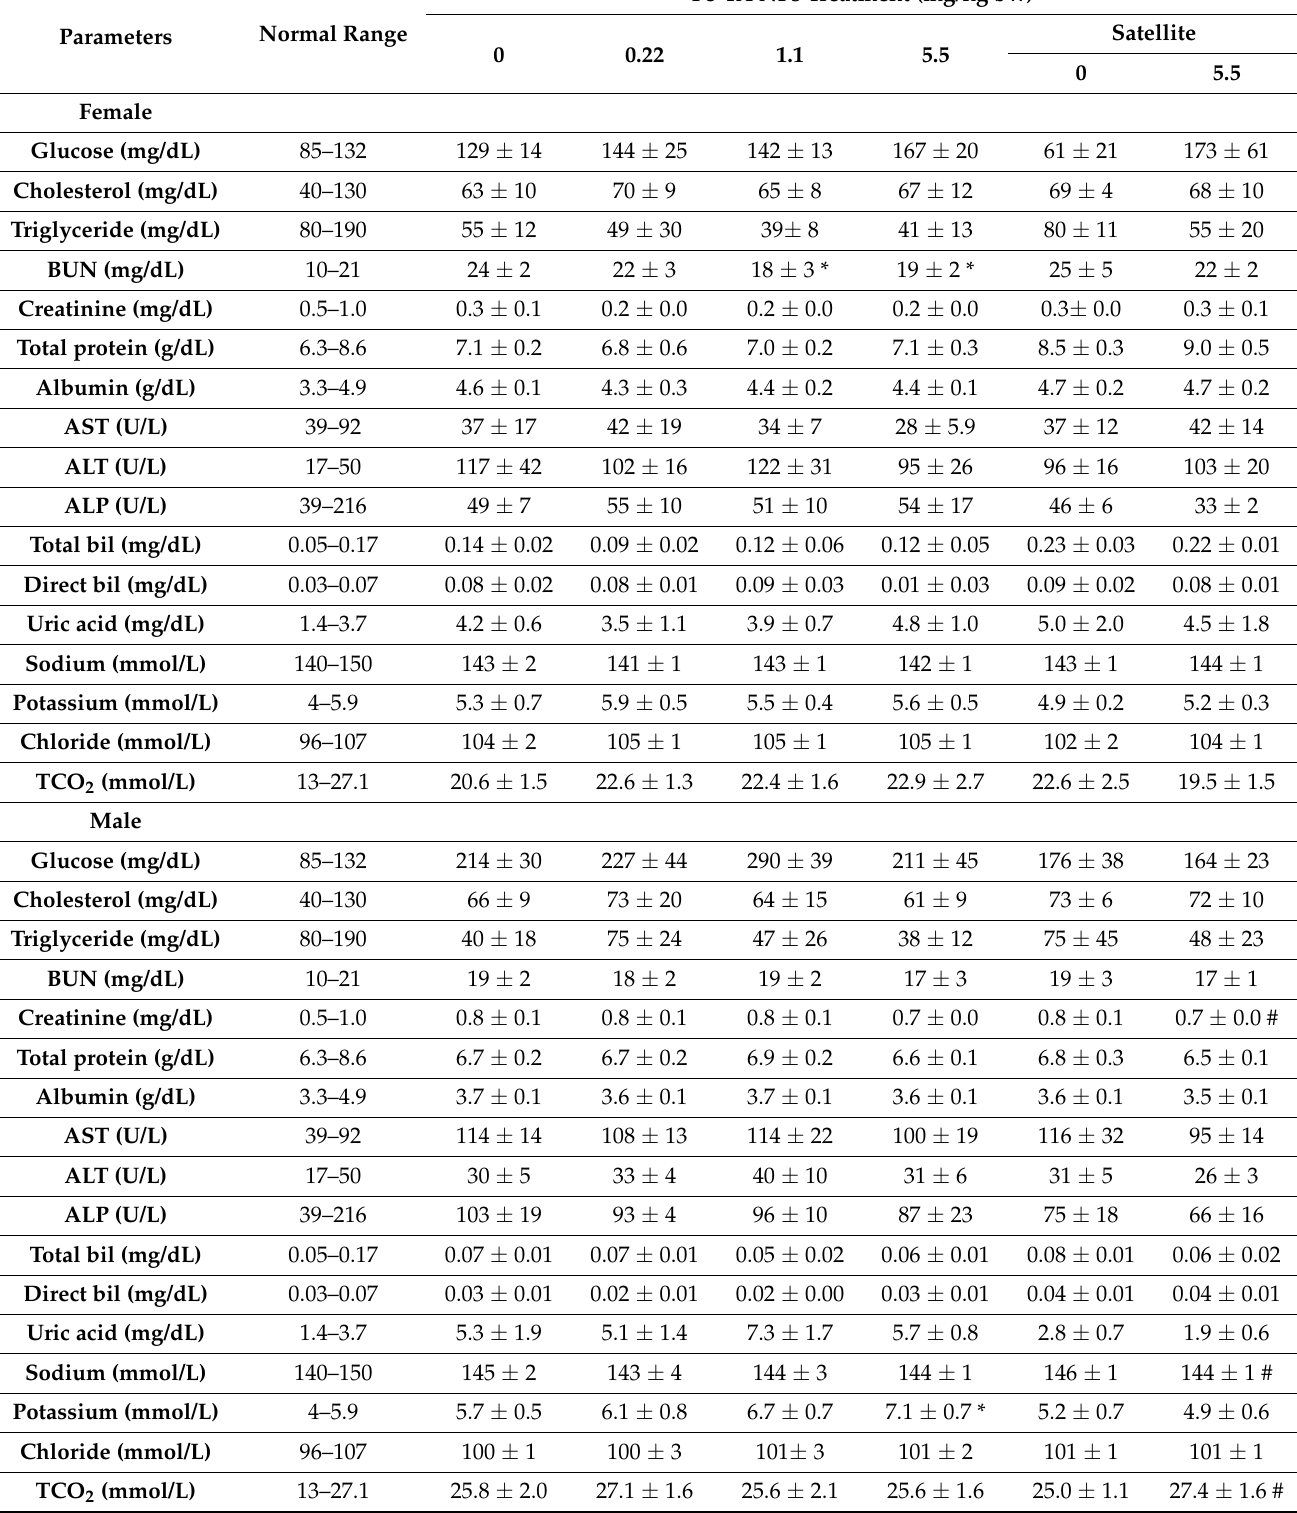
Table 3. Effect of Fe-TA NPs on biochemical profiles in rats exposed to repeated dose toxicity